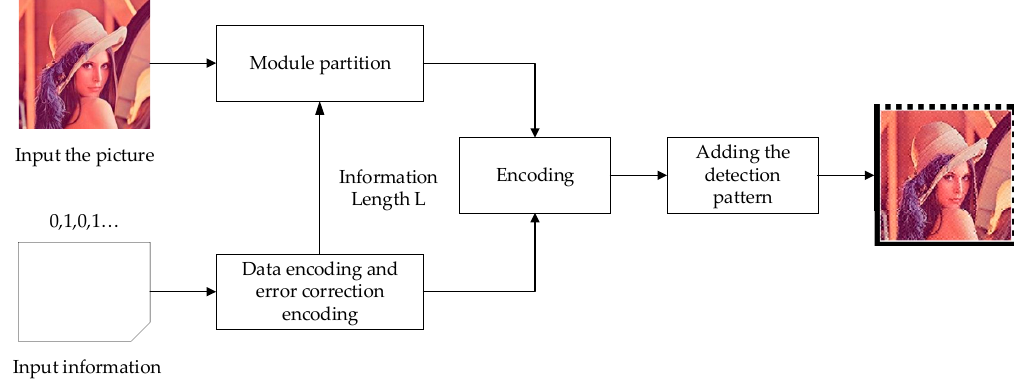
Figure 2. Customized 2D barcode encoding.